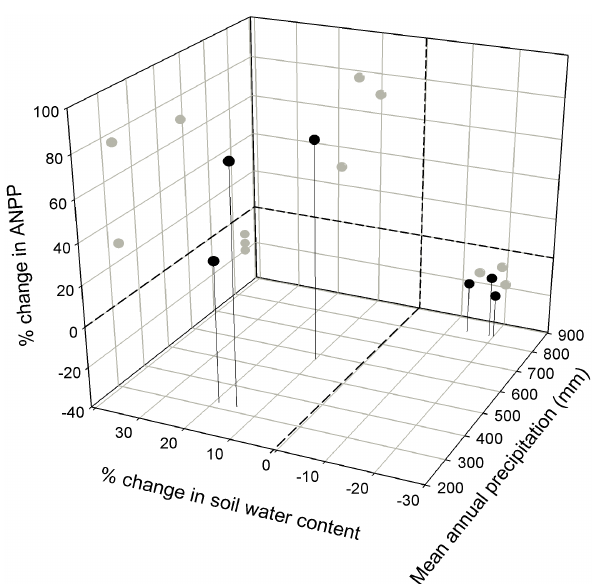
Figure 2. The effect of extreme precipitation on above-ground net primary productivity (ANPP) across a rainfall gradient. The three- dimensional plot shows the relationship between relative changes in soil water content (%) and the percent change in above-ground net primary productivity ANPP (%) due to extreme precipitation, based on the mean annual precipitation (mm) of the site. The site aridity index for each site is presented in Table 3. The black dots represent data points on the x , y and z axes. The grey dots represent where the data would fall in a two-dimensional scatter plot. Dashed lines represent the zero line, where % change in soil water content or ANPP is